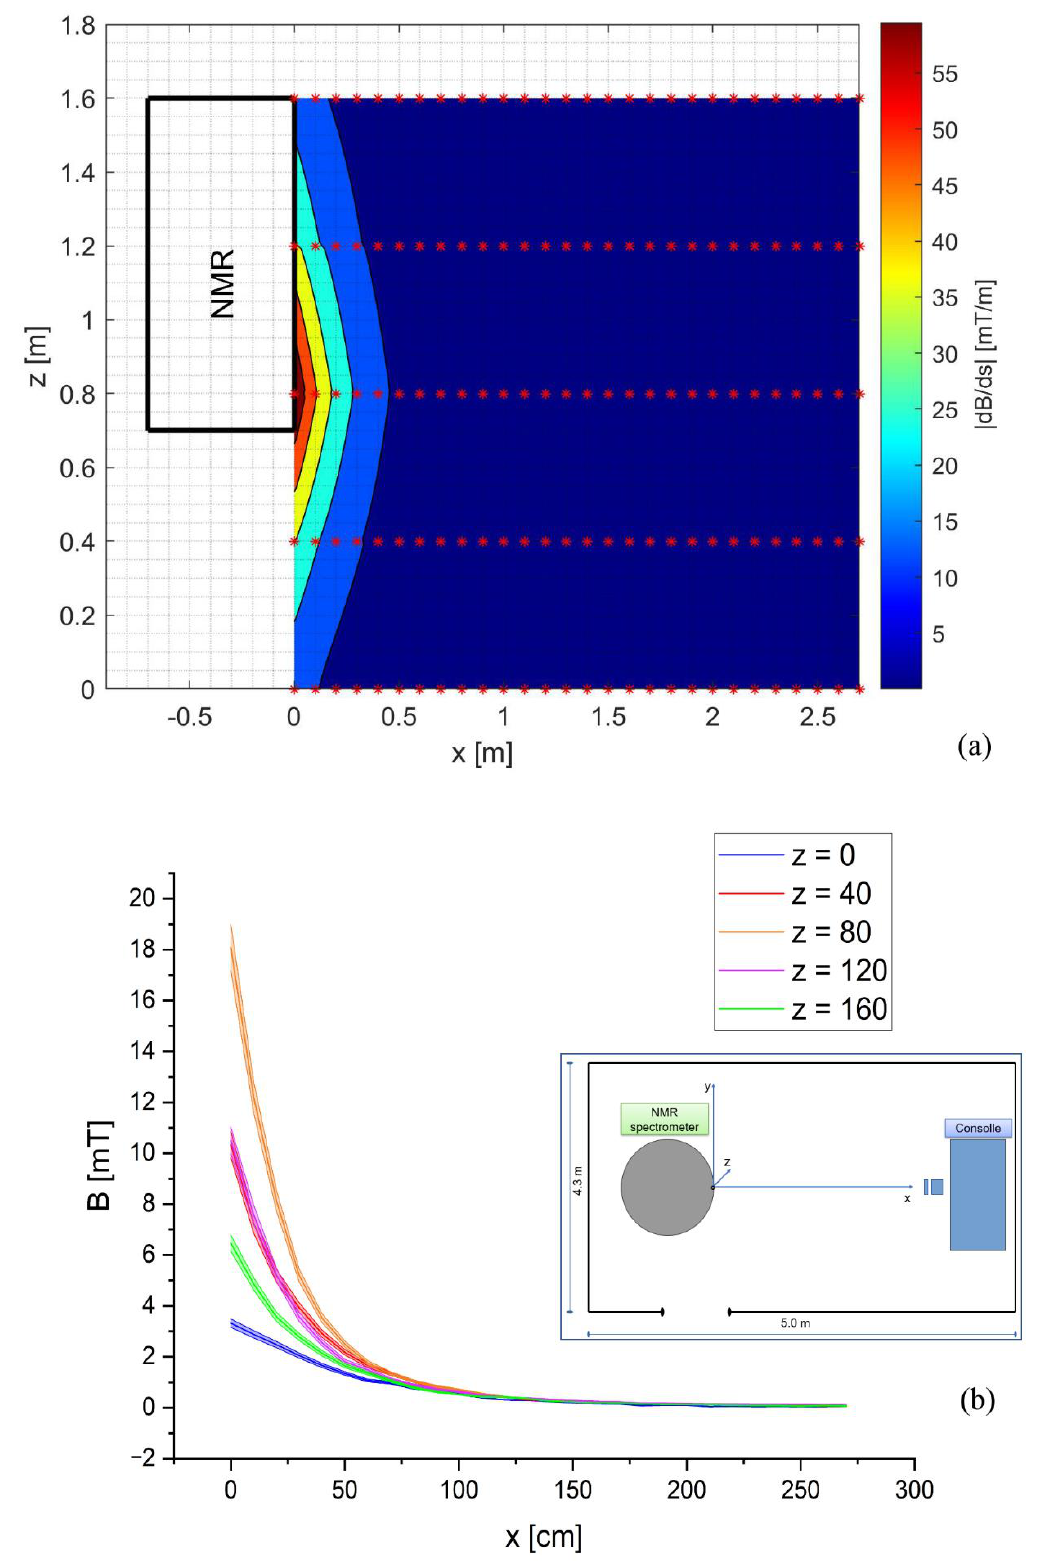
Figure 1. ( a ) Spatial gradient | dB/ds | (red stars represent points of measurement of | B |); ( b ) the trend of | B | values, measured at different heights from ground plane, and the SD depicts as gradient color. The box inside ( b ) explains the room structure, center of coordinate systems, and axis.